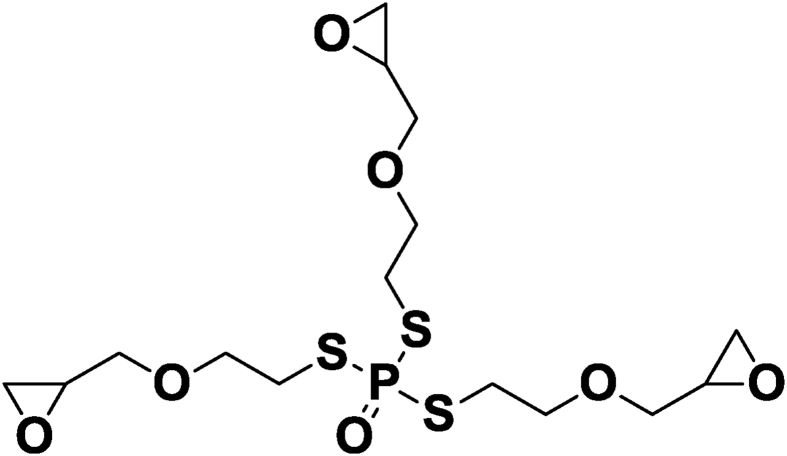
Structure of TGETMEP [20].